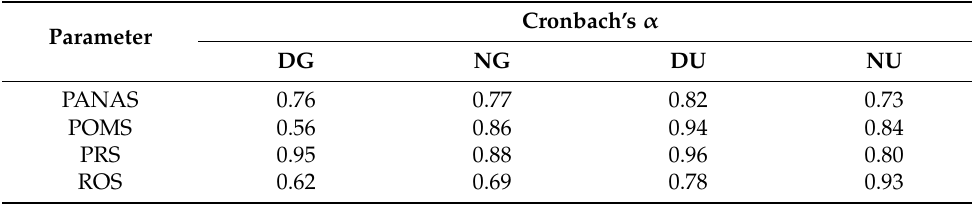
Table 4. Internal consistency of the scales in each scenario.